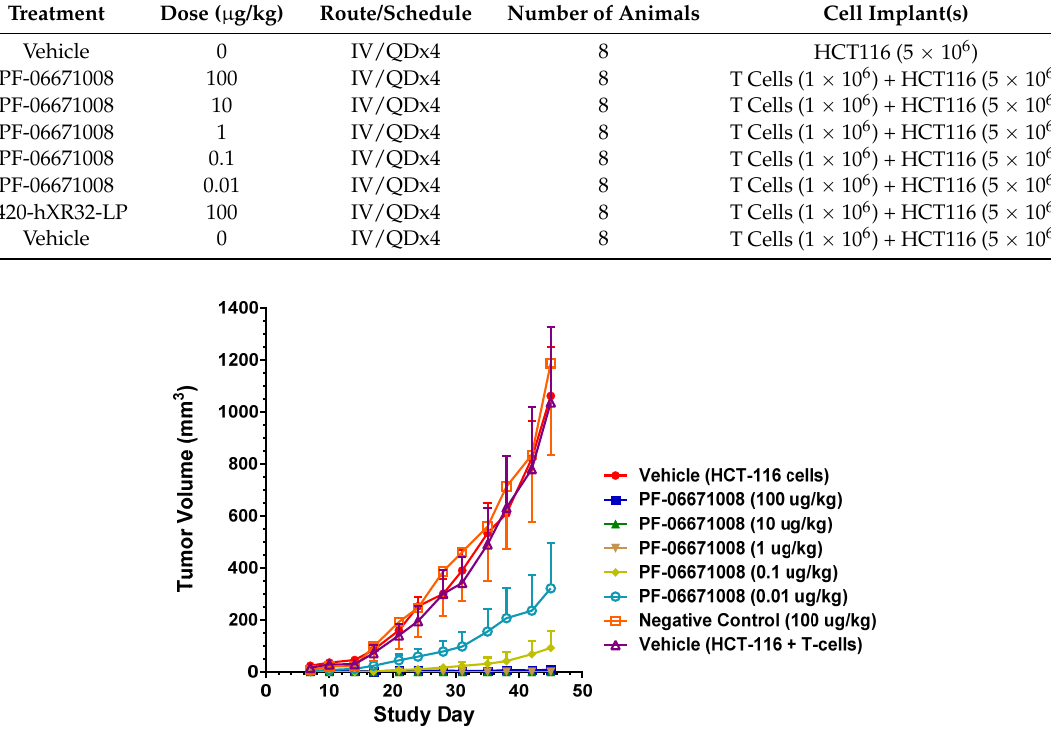
Figure 9. Inhibition of tumor growth by PF ‐ 06671008 in mice implanted with human colorectal tumor cells (HCT ‐ 116) in the presence of activated human T cells. Female NOD/SCID mice ( n = 8/group) were implanted subcutaneously (SC) with HCT ‐ 116 tumor cells + human T cells on Day 0 followed by treatment with vehicle control, 100 μ g/kg control DART (4420 ‐ hXR32 ‐ LP), or 0.01 to 100 μ g/kg PF ‐ 06671008 on Days 0–3 for a total of four doses administered intravenously (IV). Tumor volume was measured through Day 45 (mean ± standard error of mean (SEM) is shown).